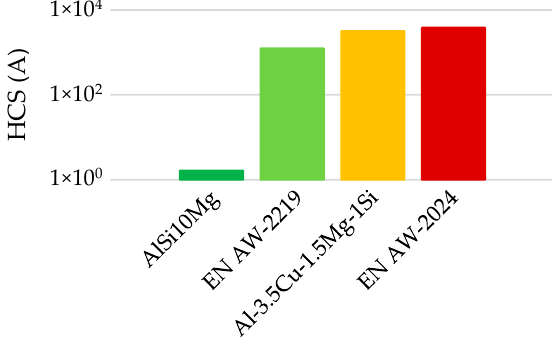
Figure 3. HCS (A) of different aluminum alloys.